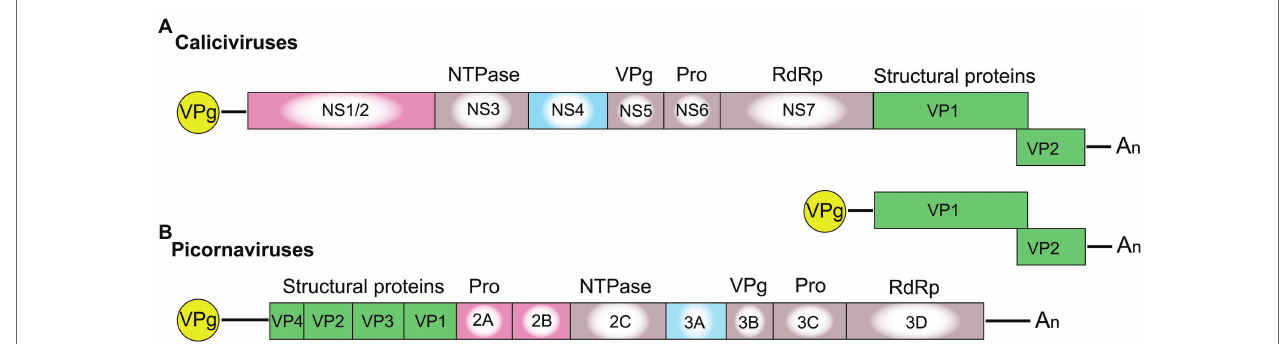
FIGURE 1 | Schematic representation of the genome organization for a typical (A) calicivirus and (B) picornavirus. Untranslated and translated sequences are depicted as lines and boxes, respectively. Structural (capsid) proteins are shown in green (note that VP1 and VP2 in lagoviruses are usually referred to as VP60 and VP10, respectively); the signature proteins of the picornavirus-like superfamily are shown in gray, namely the helicase (NTPase), VPg, protease (Pro), and the RNA- dependent RNA polymerase (RdRp); the non-structural calicivirus proteins NS1/2 and their positional homologs in picornaviruses (2A, 2B) are shown in pink; and the non-structural calicivirus protein NS4 and its homolog in picornaviruses (3A) are shown in blue. Covalently linked VPg proteins at the 5 ' end are shown in yellow, and An represents the poly(A) tail at the 3 '